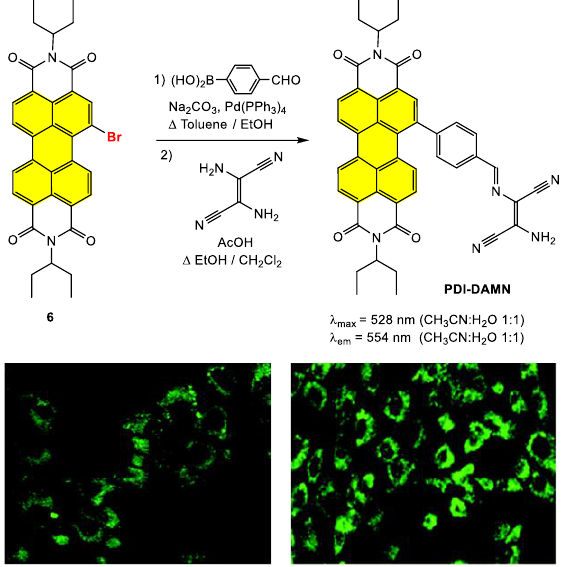
Figure 19. Structure of PDI-DAMN; fluorescent imaging of exogenous ClO − anion in MG-63 cells after incubation with PDI–DAMN (10 mM) then with ClO − anion (left); fluorescent imaging of endogenous ClO − anion in MG-63 cells after incubation with lipopolysaccharides (LPS) and phorbol myristate (PMA), then with PDI–DAMN . Images have been taken at magnification 40×. Reprinted with permission from Ref. [125]. Copyright 2019 Royal Society of Chemistry.